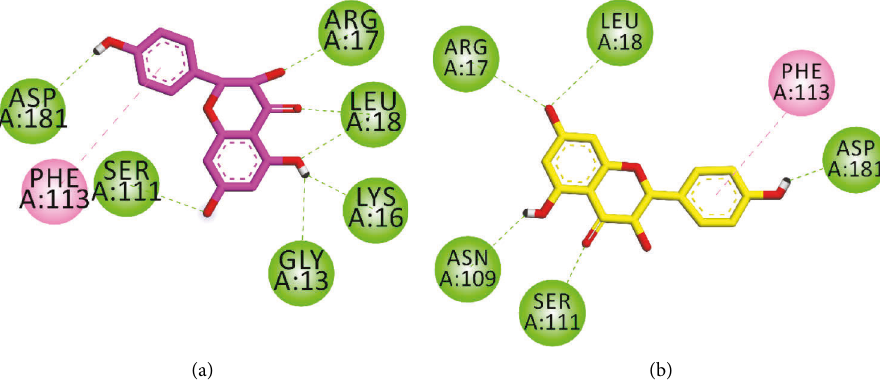
Figure 4: 2-D interaction plots of isolated flavonoid obtained via (a) MOE dock (b) AutoDock into the active site of Lm PTR1 (PDB ID �